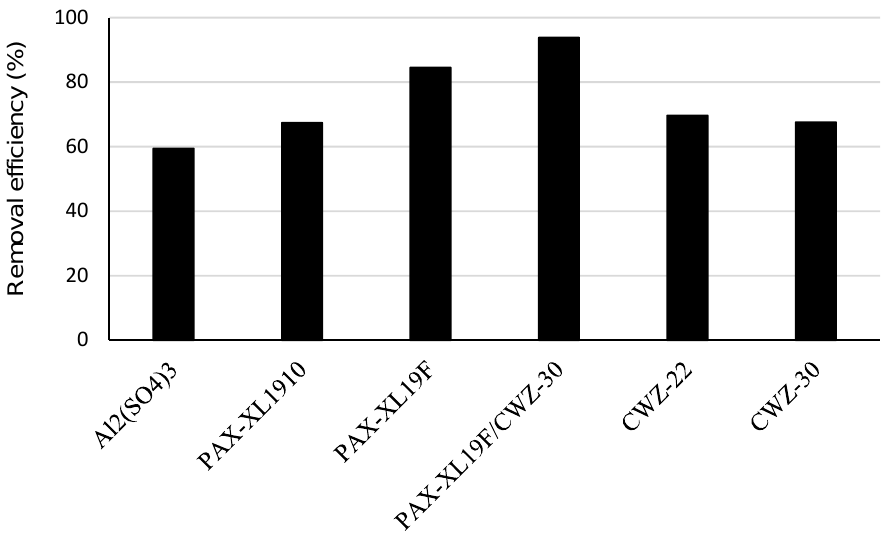
Figure 2. Removal efficiency of sum PAH standardized in the Council Directive 98/83/EC on the quality of water intended for human consumption.